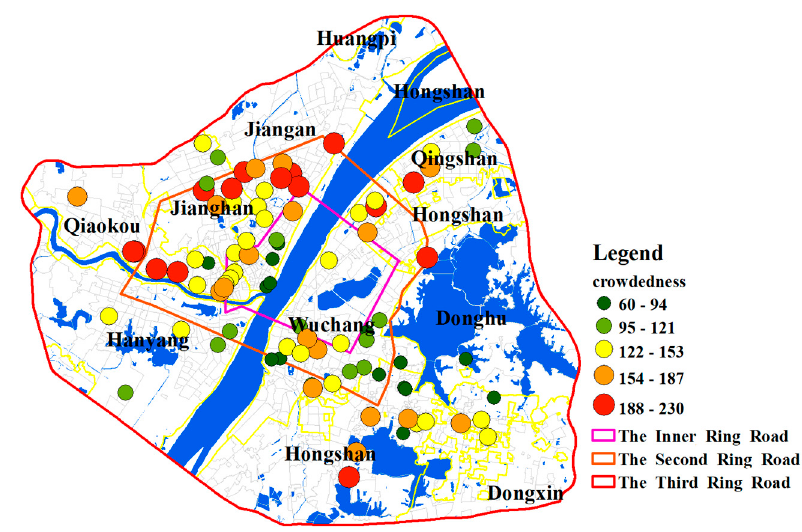
Figure 11. The crowdedness of hospitals.